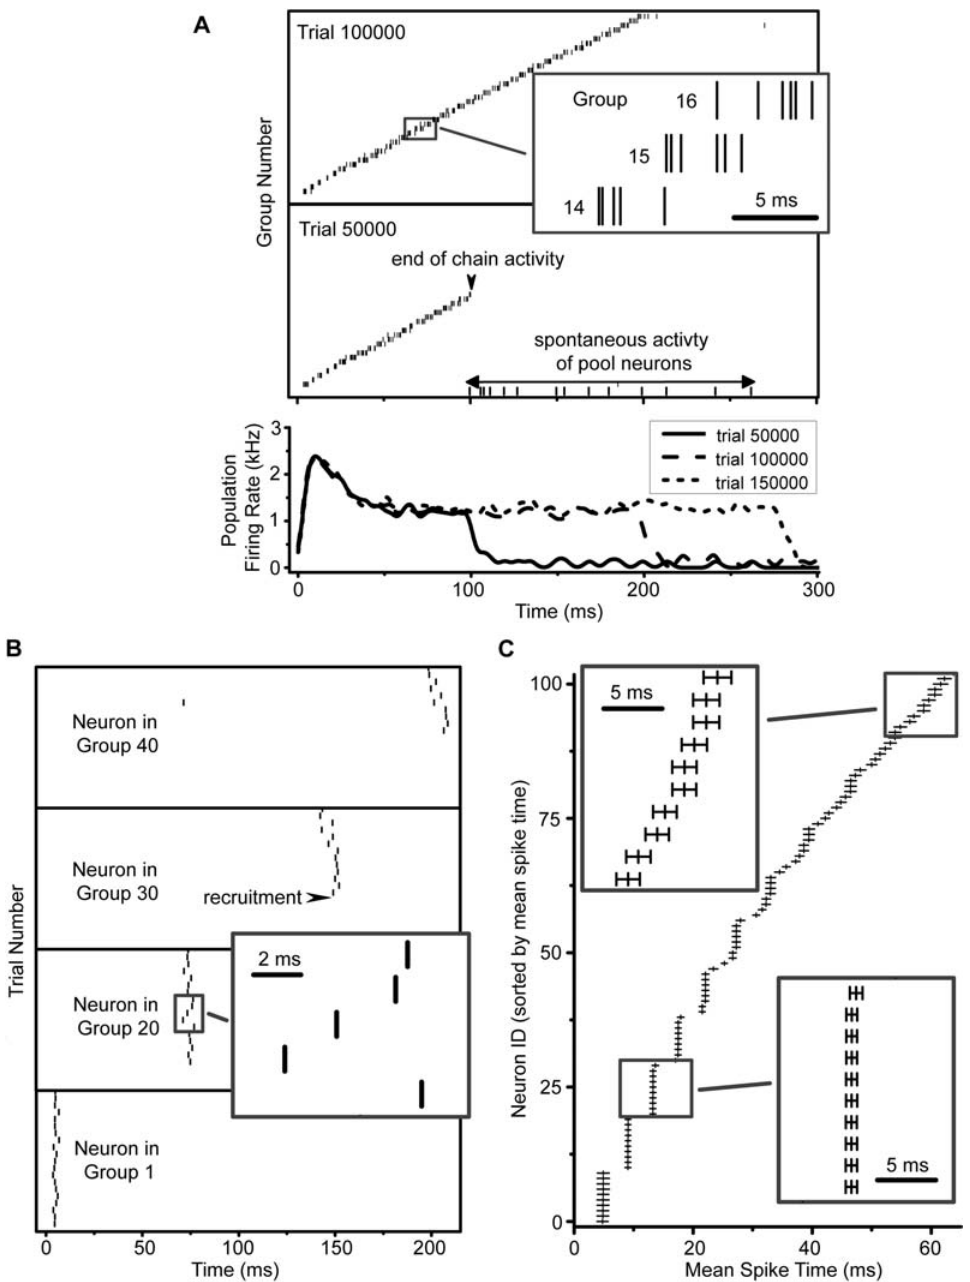
Figure 4. Spike timings of neurons in the network shown in Figure 3. (A) Raster plots (upper) show spike times of neurons for two different stages of the development. Spikes of neurons in the same group are shown in the same row. Spikes of all pool neurons are shown in the same row at the bottom. In trial 50000, there are 21 groups, and the chain activity lasts for approximately 100 ms, after which spontaneous activity of the pool neurons begins. By trial 100000, there are 39 groups, and chain activity lasts about 200 ms. The inset shows a detail of spikes from three successive groups; spikes of a group cluster together, but those of successive groups can overlap. The duration of the chain activity and its growth in time is also demonstrated with the population firing rate (lower). Spikes of all neurons were convolved using a Gaussian kernel with a standard deviation of 3 ms to compute the population firing rate. The firing rates for three different trials—50000, 100000, and 150000 (raster not shown)—are plotted versus time. The duration of chain activity increases linearly with the number of trials (data not shown). (B) Raster plots across trials for select neurons show how precise spike timings emerge. Each panel shows spike data across 300000 trials sampled every 10000 th trial for that neuron; the group to which each neuron belongs is indicated in the panel. The neuron in Group 1 is a TN, and therefore is induced to spike at the beginning of each trial (lower panel). The other neurons (upper panels) are recruited into the synfire network at later trials; thus, early on, they only spike spontaneously. As neurons from the chain strengthen synaptic connections onto each neuron, it begins to spike with high accuracy. Inset shows a detail from a neuron in Group 15. (C) Raster plot of mean spike times (vertical dashes) and spike timing jitters (horizontal error bars) for the earliest 100 neurons in the chain. The network—formed over 350000 trials—was simulated for an additional 1000 trials, and the spike data for all neurons was recorded. The first spike time of each neuron was averaged across all 1000 trials, and the jitter (standard error) of the first spike time was calculated. Only those neurons that spiked in at least one-half of all trials are shown. Insets show details from two different time periods. Note that neurons with smaller latency have smaller spike timing jitter.